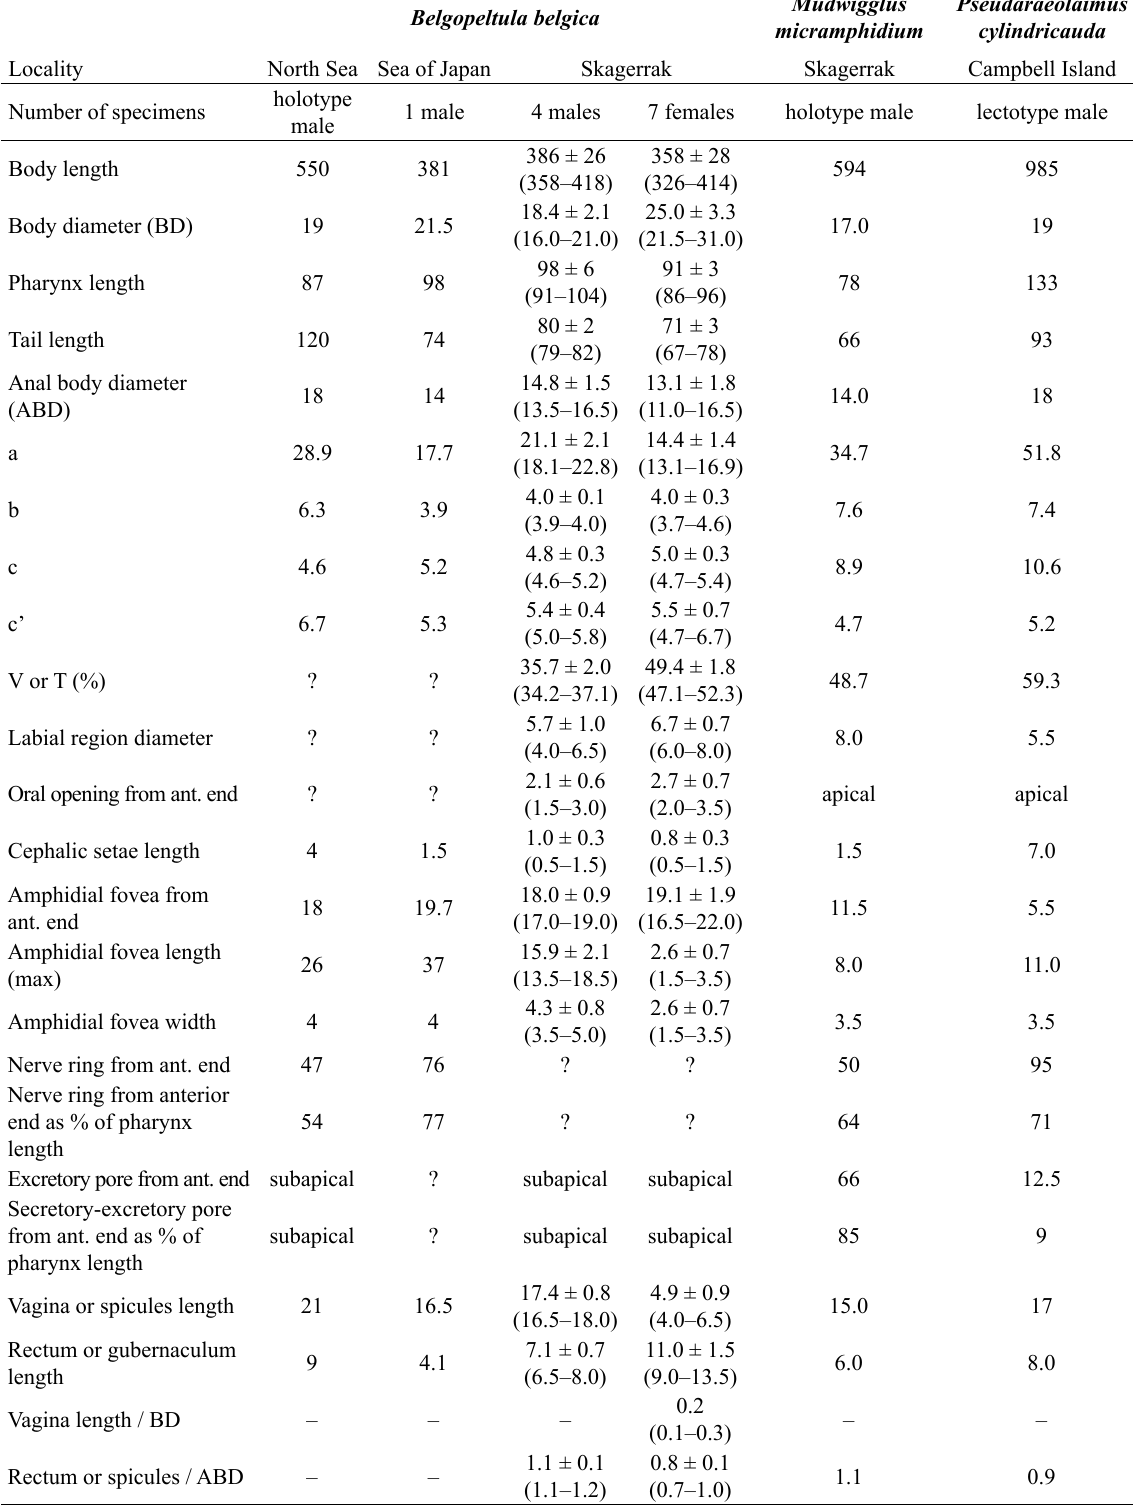
Table 1. Measurements (in µm) of Belgopeltula belgica (Vincx & Gourbault, 1992) gen. et comb. nov., Mudwigglus micramphidium sp. nov. and Pseudaraeolaimus cylindricauda (Allgén, 1932) comb. nov. (presented as mean ± SD and (range) where